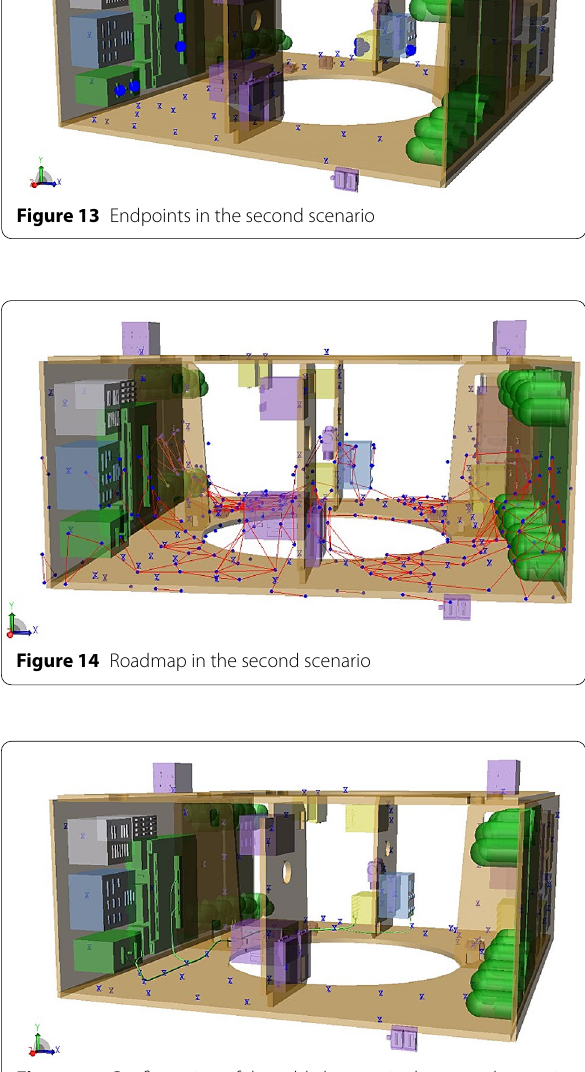
Figure 15 Configuration of the cable harness in the second